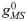
Synaptic weight distributions in the presence of STDP rules.(a) Histogram of the g
MS values. Inset: AS provides limited weight distribution even without an upper boundary. However, in the DS regime some synapses can grow unlimited. (b) Time evolution of four randomly chosen synaptic weights starting from different initial conditions in the AS and DS regimes. Each color represents a different simulation in which all initial synaptic conductances gMS0 were the same. The inhibitory conductances in the Slave-Interneuron population is g
IS = 4 nS in the AS regime, while g
IS = 16 nS in the DS regime.